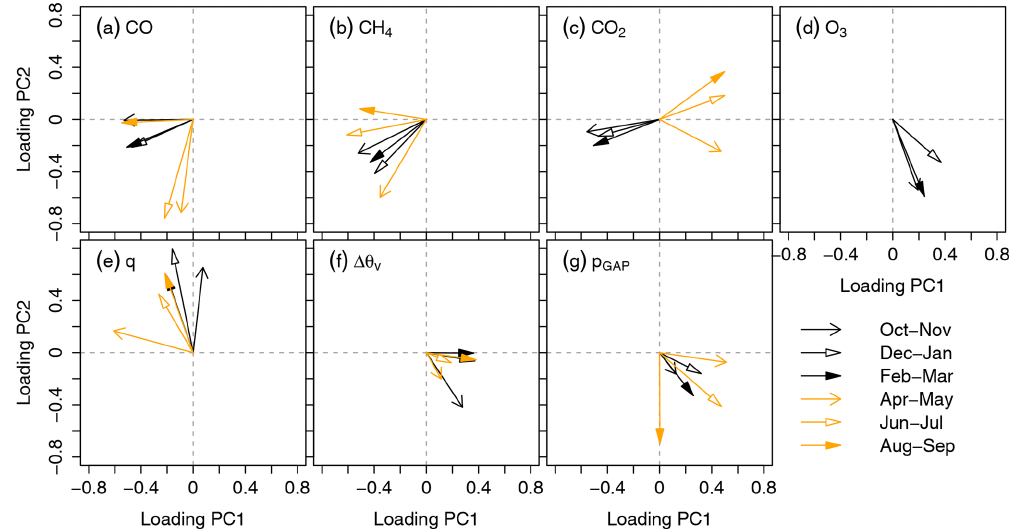
Figure 6. Loadings of the input variables on the first (PC1) and second principal component (PC2) for each 2-month period. O 3 was only used as an input variable in the winter half year (black